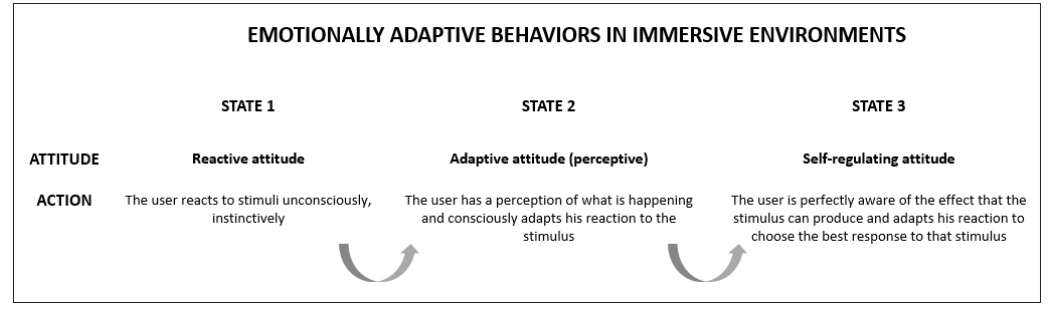
Figure 1. Behavioral change during continuous exposure to stimuli generated in immersive